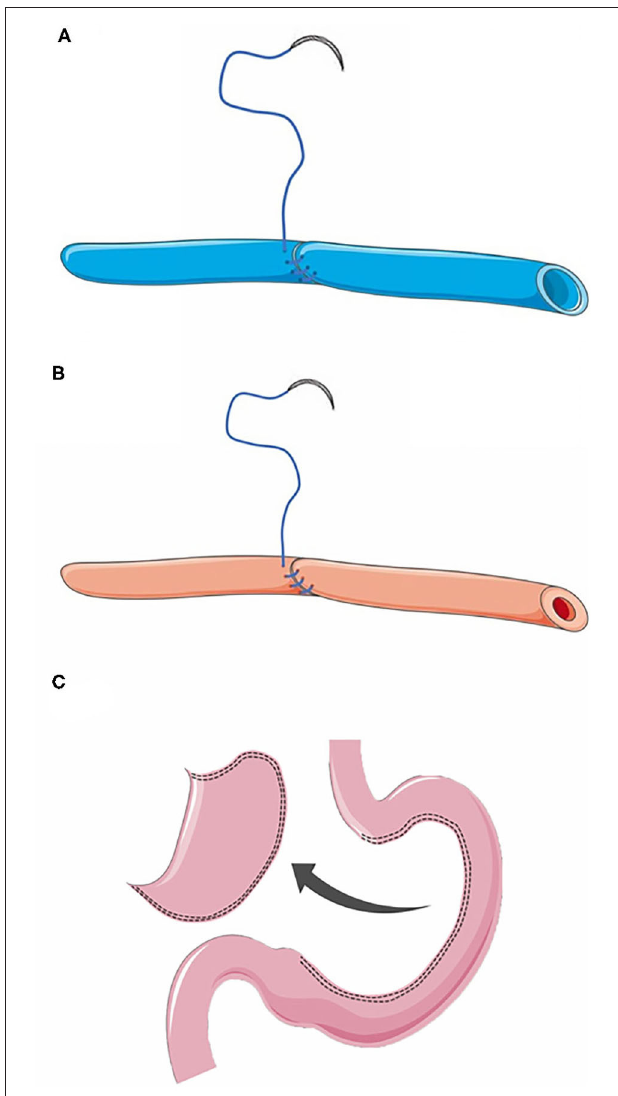
FIGURE 2 | (A) Anastomosis of the right gastroepiploic vein. (B) Anastomosis of the right gastroepiploic artery. (C) Preparation of a gastric conduit without resection of gastric fundus during the gastric conduit construction until cervical anastomosis was completed.